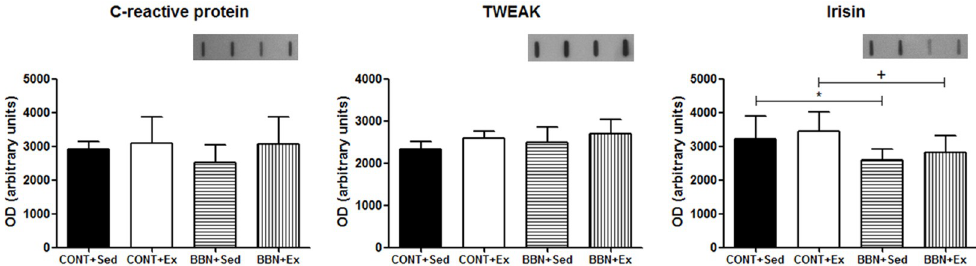
Values are expressed as mean ± standard deviation of n = 15 for BBN groups and n = 7 for CONT